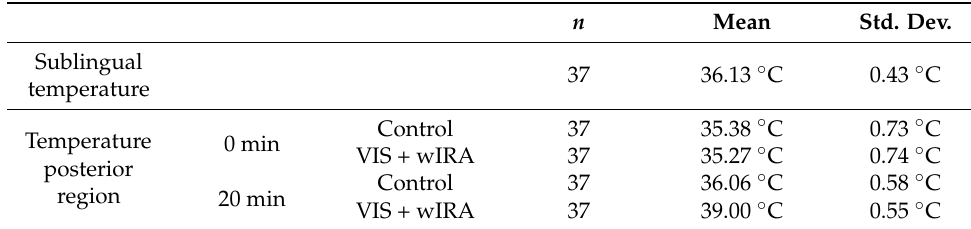
Table 3. Temperature measurement before and 20 min after VIS + wIRA treatment.